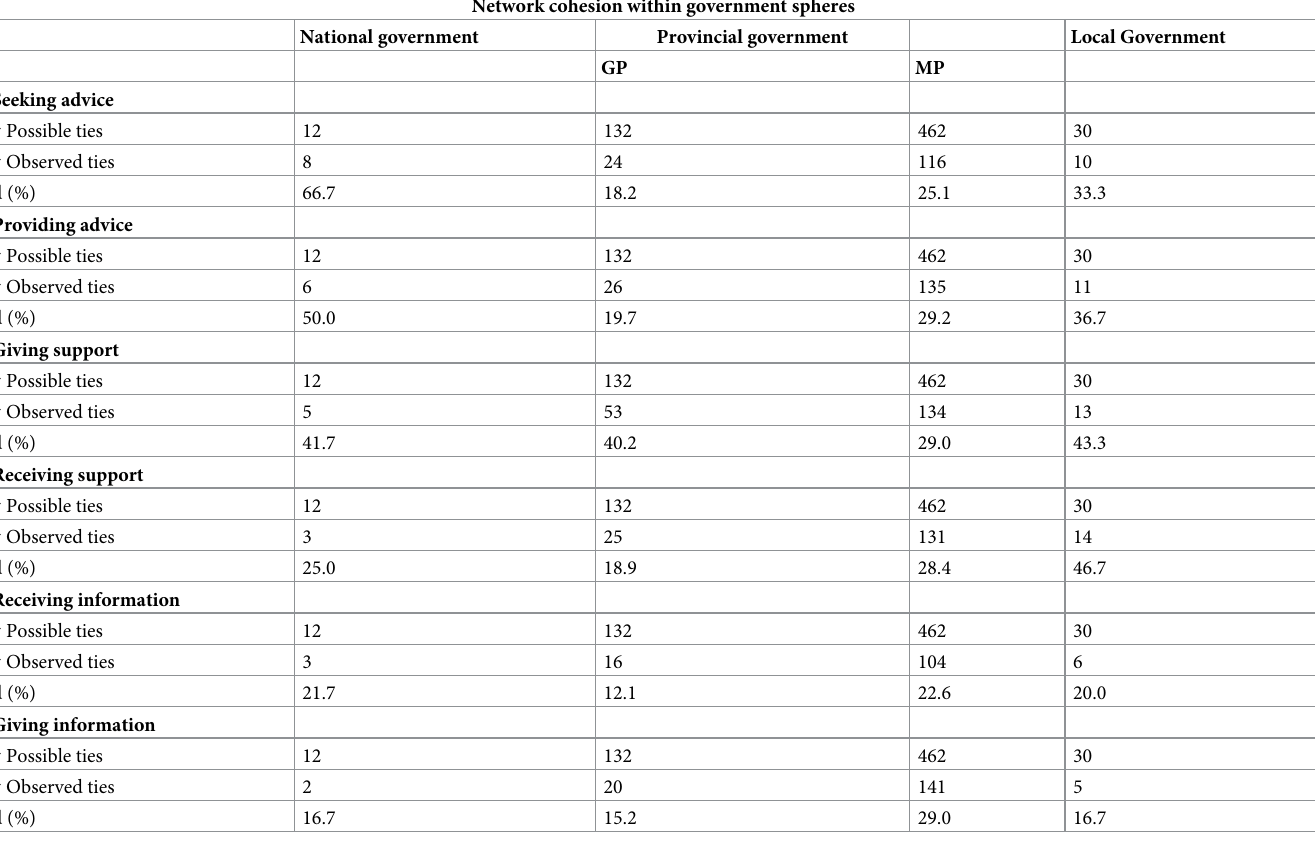
Network cohesion within government spheres